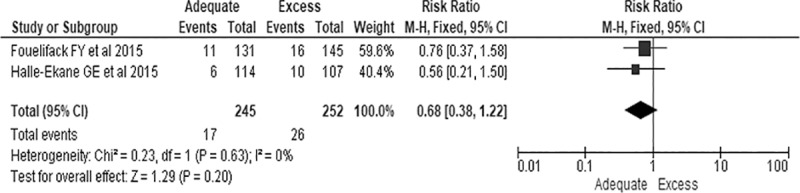
The association of excess gestational weight gain and macrosomia in sub-Saharan Afric.